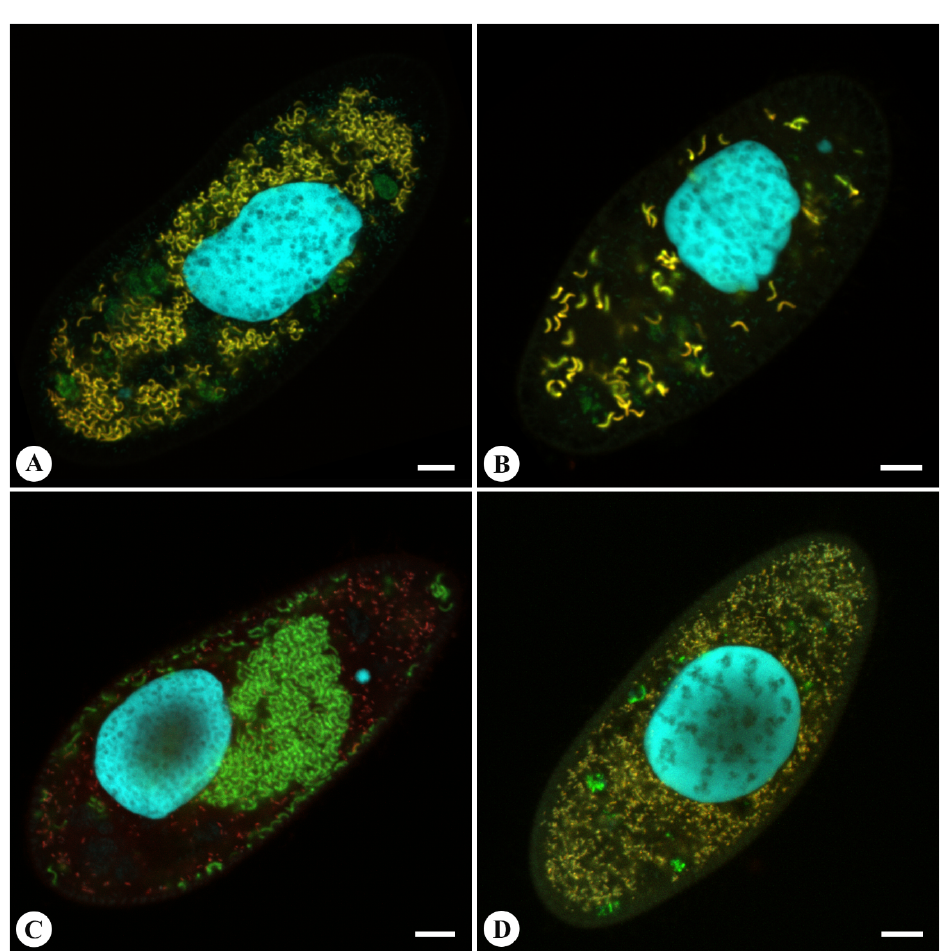
Figure 5. Fluorescent in situ hybridization of the endosymbionts in cells of P. nephridiatum , Confocal Laser Scanning Microscope (CLSM); ( A , B ) BMS16 ‐ 23 and BMS17 ‐ 1 cells labeled with 16S_Myst965 probe (red) and the universal eubacterial probe Eub338 (green) counterstained with DAPI (cyan), FA concentration 15% and 30%, respectively; ( C ) BMS17 ‐ 1 cells labeled with 16S_MegVen1226 (red) and 16S_Myst965 (green) probes counterstained with DAPI (cyan), FA concentration 20%; ( D ) BMS16 ‐ 34 cells labeled with 16S_MegVen1226 (red) and the universal eubacterial probe Eub338 (green) counterstained with DAPI (cyan), FA concentration 0%. Scale bar 10 μ m.